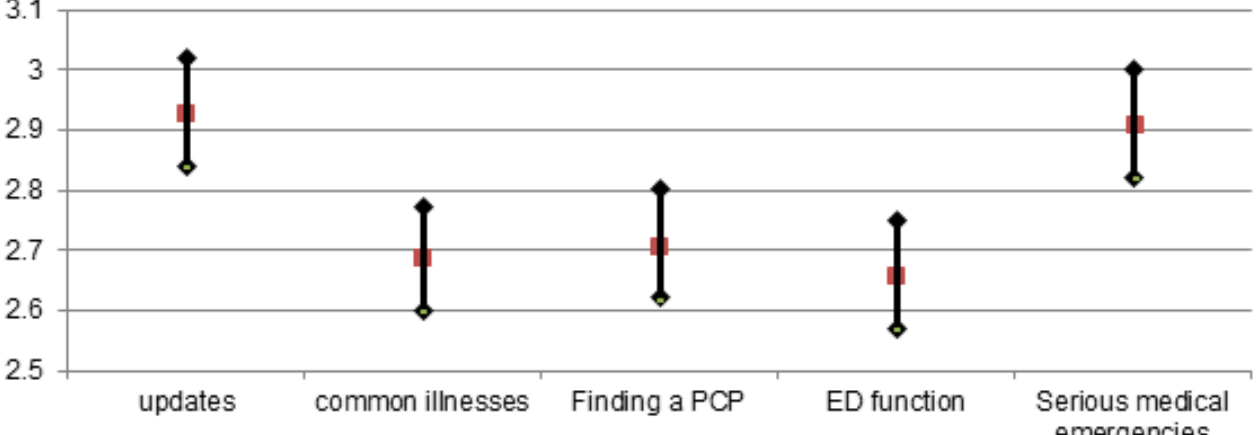
Figure 1. Rated level of importance of information available in the emergency department waiting room on a scale from 1 (not impor- tant) to 4 (very important); mean value with 95% CI